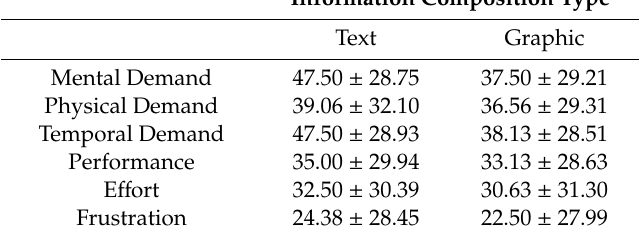
Table 2. Summary of NASA Task Load Index (NASA-TLX) subscales scores (mean and standard deviation).